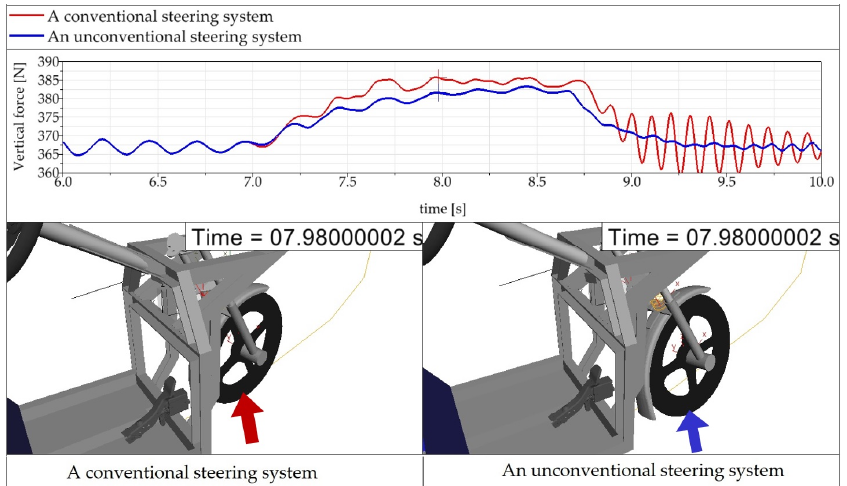
Figure 6. Position of the modified tire casing relative to the reference height when the steering wheel is turned at: ( a ) 0°; ( b ) 60°; ( c ) 90°.